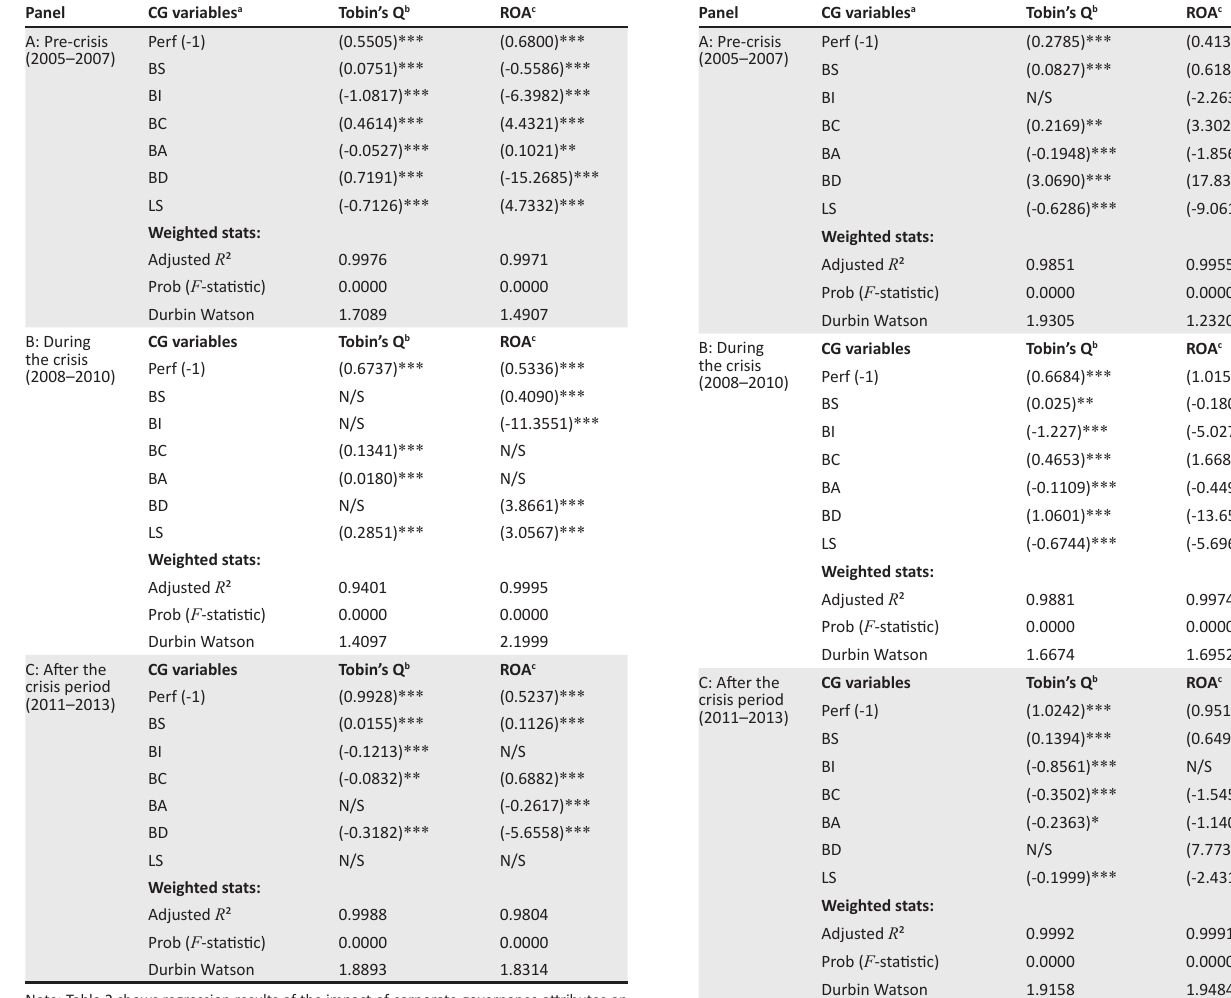
TABLE 3: Regression results of the impact of corporate governance attributes on Tobin’s Q and Return on Asset for the consumer services industry.